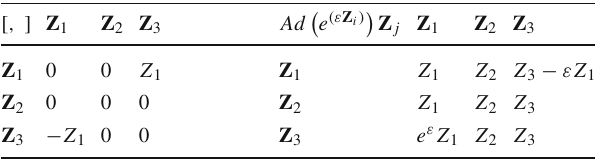
Table 5 Commutators and Adjoint representation of the admitted Lie point symmetries for the Karmarkar condition for the model